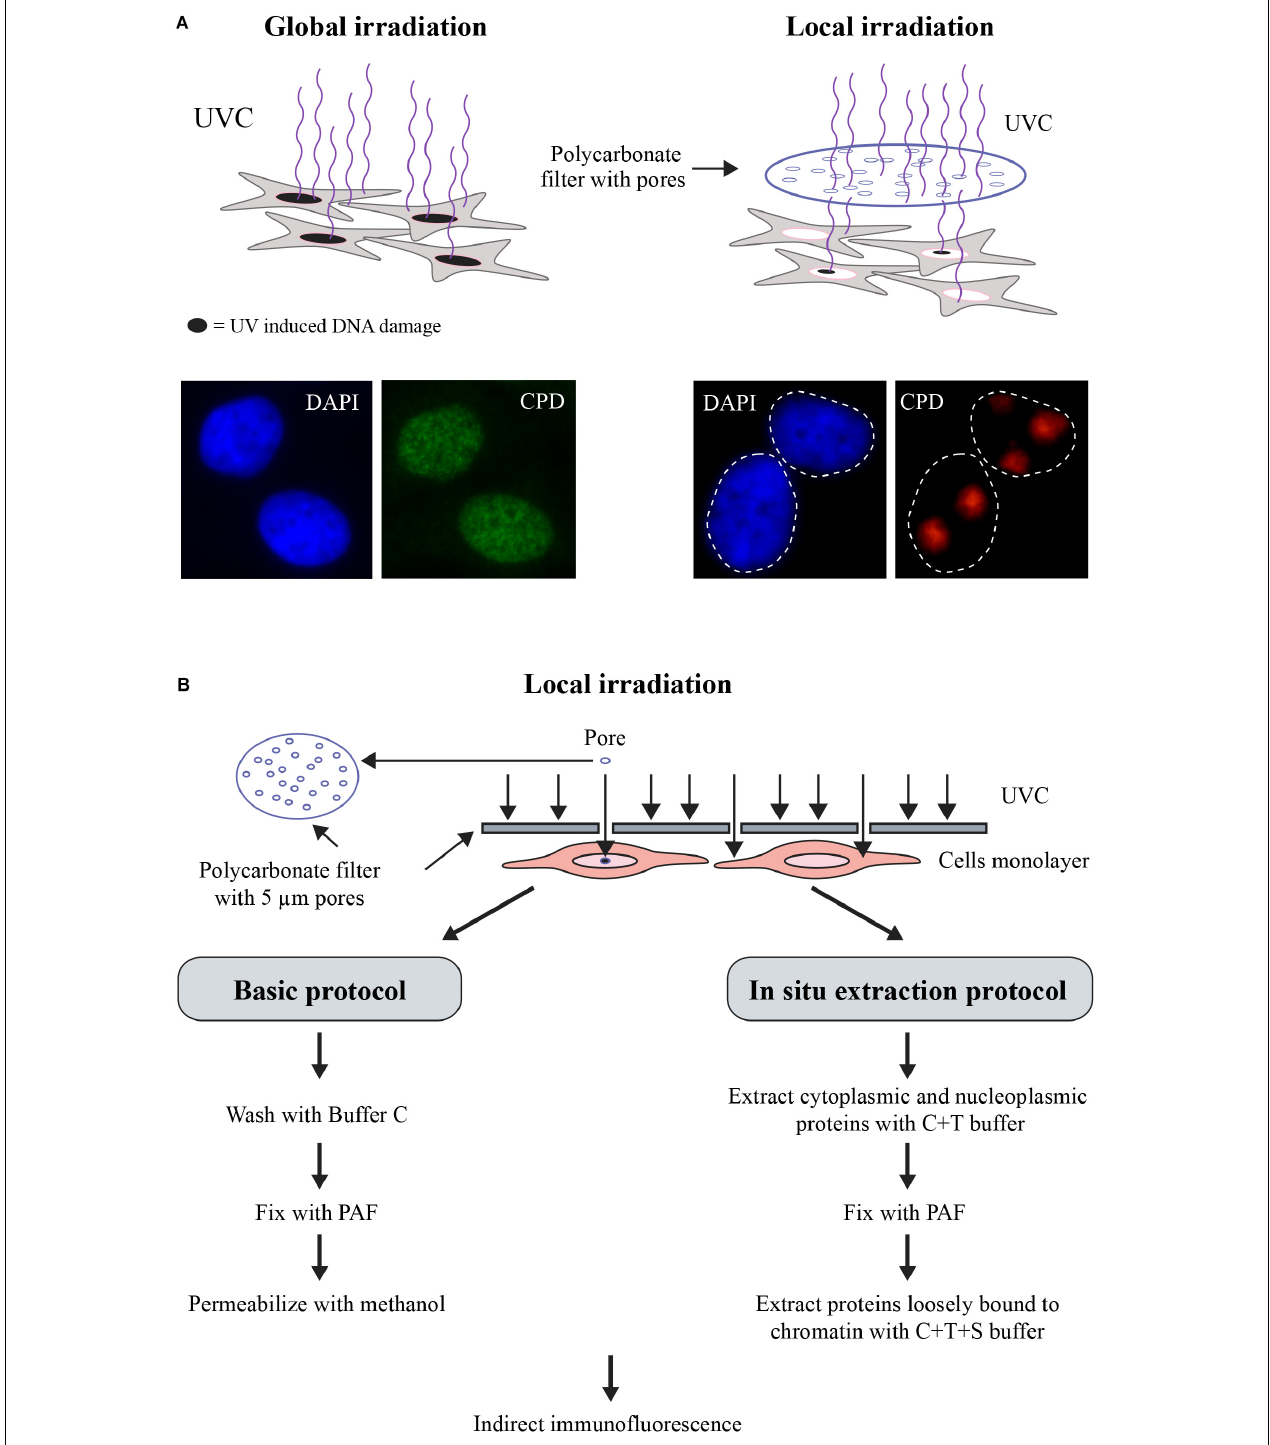
FIGURE 1 | (A) Scheme for Global or Local UVC-irradiation. The cells are exposed to UVC either unfiltered for global irradiation (left panel) or through an isopore polycarbonate filter with 3, 5, or 8 µ m holes (right panel). DNA damage induced by either protocol of irradiation was detected by indirect immunofluorescence using an antibody specific for UV-induced photolesions. DAPI staining is carried out to define the nuclei. (B) Flow chart for the two versions of the local irradiation protocol. In the basic version (left), locally irradiated samples are fixed and processed for immunofluorescent detection, whereas in the in situ extraction protocol (right), the locally irradiated samples are processed for removal of non-DNA bound proteins prior to and after fixation step followed by immunofluorescent detection DNA-bound proteins. The steps and the buffer compositions are described in the main text.